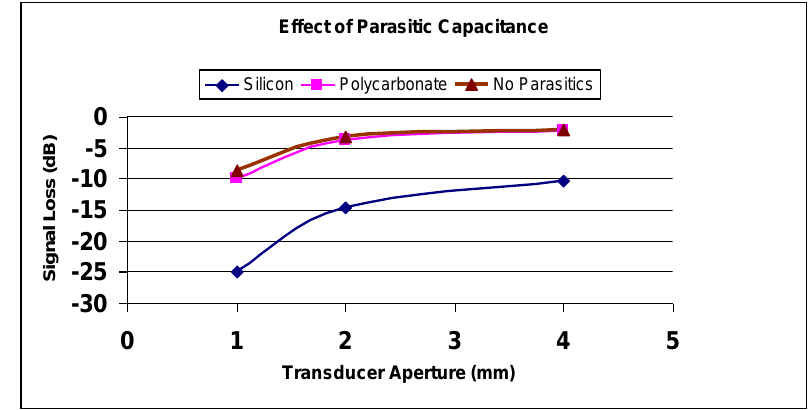
Figure 6. Effect of parasitic capacitance on signal loss for various aperture transducers. Polycarbonate devices show lower signal loss and comparable to losses from devices having no parasitic capacitances.